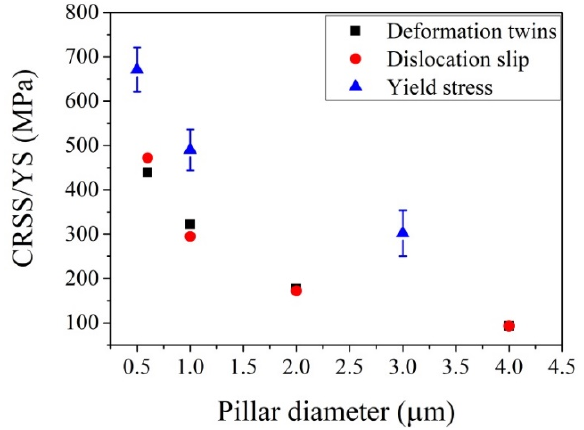
Figure 13. Critical resolved shear stress (CRSS) or yield stress (YS) for twinning and slip in small- sized single-crystal pillars (Fe-22Mn-0.6C in wt.%). The data are extracted from studies [90,144].